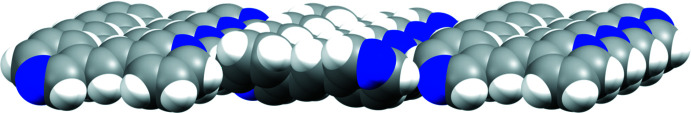
Edge-on view of sheets encompassing neighboring mol­ecules of 3,3′-bpe supported by C—H⋯N and C—H⋯π inter­molecular inter­actions.